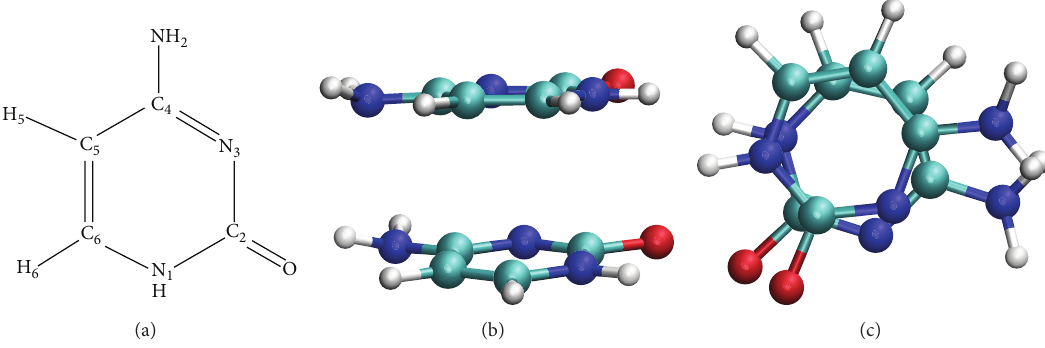
Figure 1: Structure and atomic labeling for the stacked cytosine molecules.